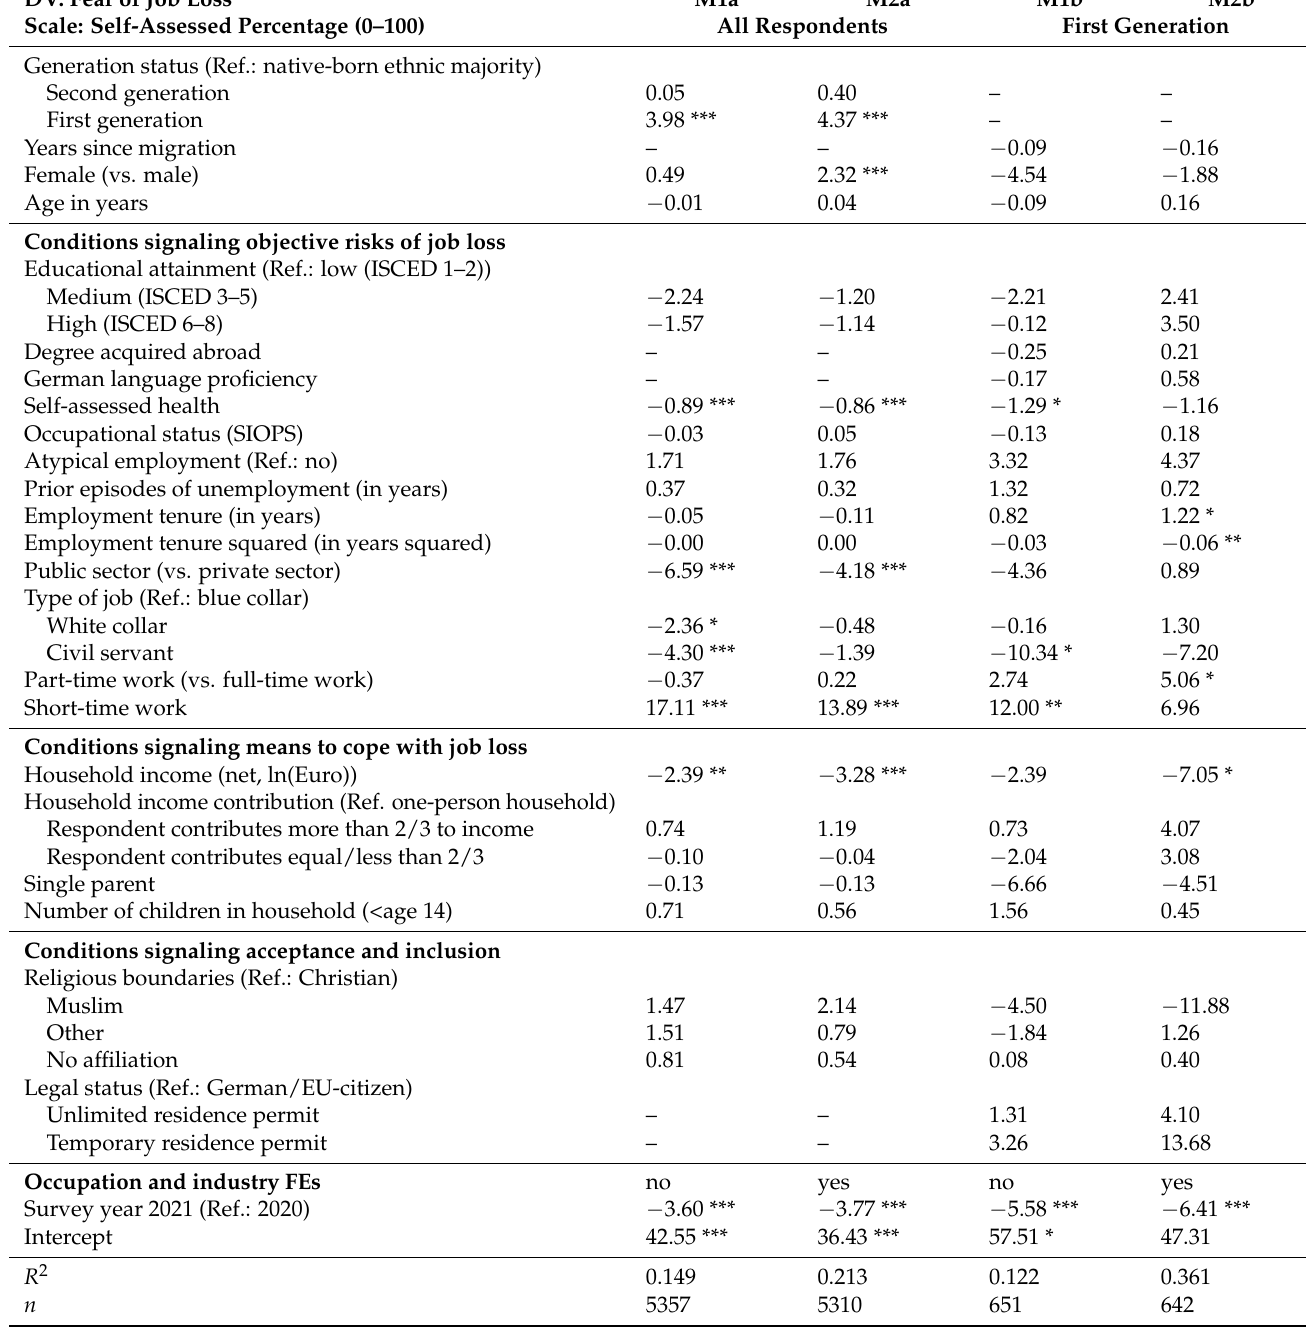
losing one’s job resembles that of the majority. As illustrated in Figure 1, the first generation stands out as the group that is most vulnerable to subjective JI, while the patterns for the second generation are indistinguishable from those of the native-born ethnic